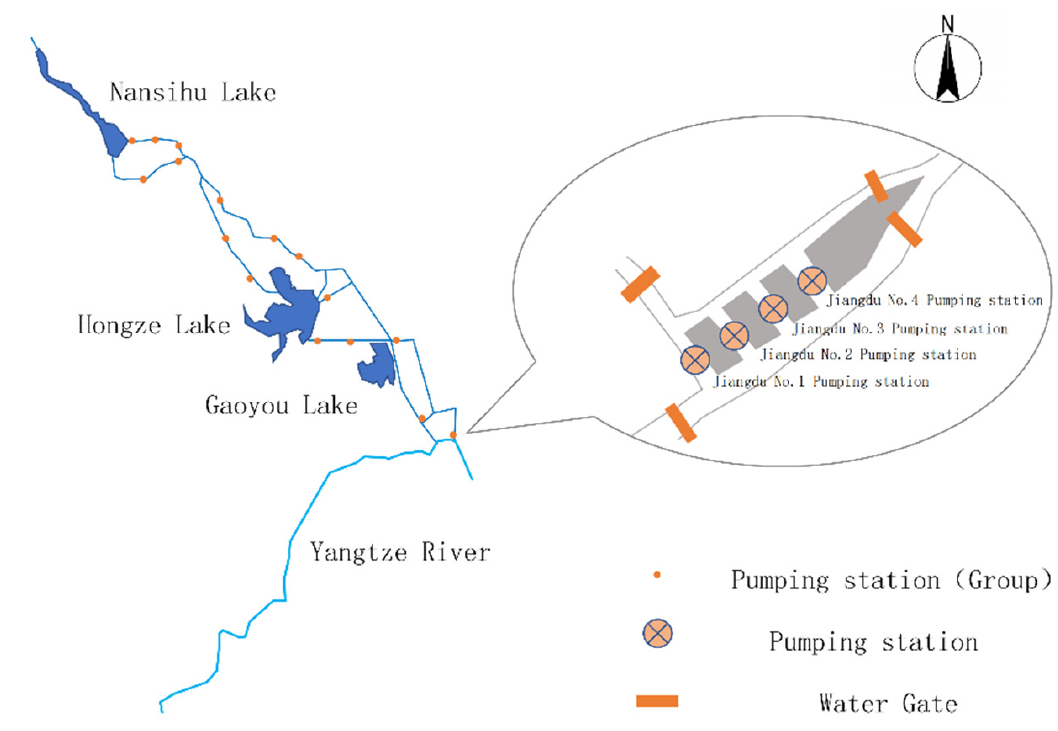
Figure 2. Jiangdu parallel pumping station group geographical location and layout. Table 1. Basic information on the Jiangdu parallel pumping station group.